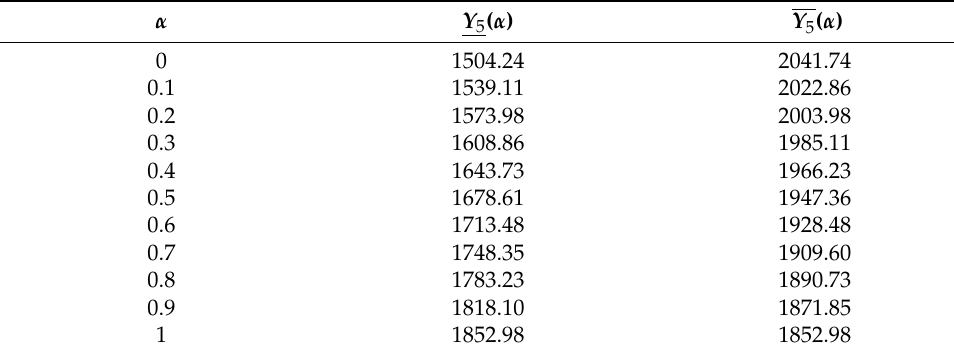
Table 3. Triangular approximation of income in the period t =